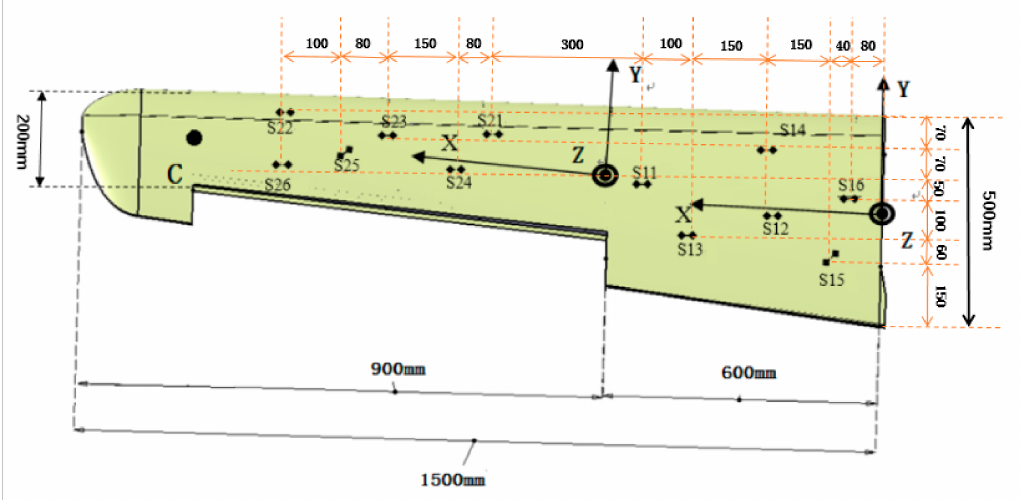
Figure 13. Finite element model of wing with variable cross section.